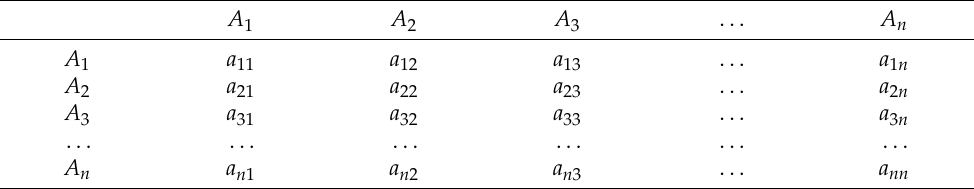
Table 1. The degree of importance of the evaluation index of the obstacle avoidance